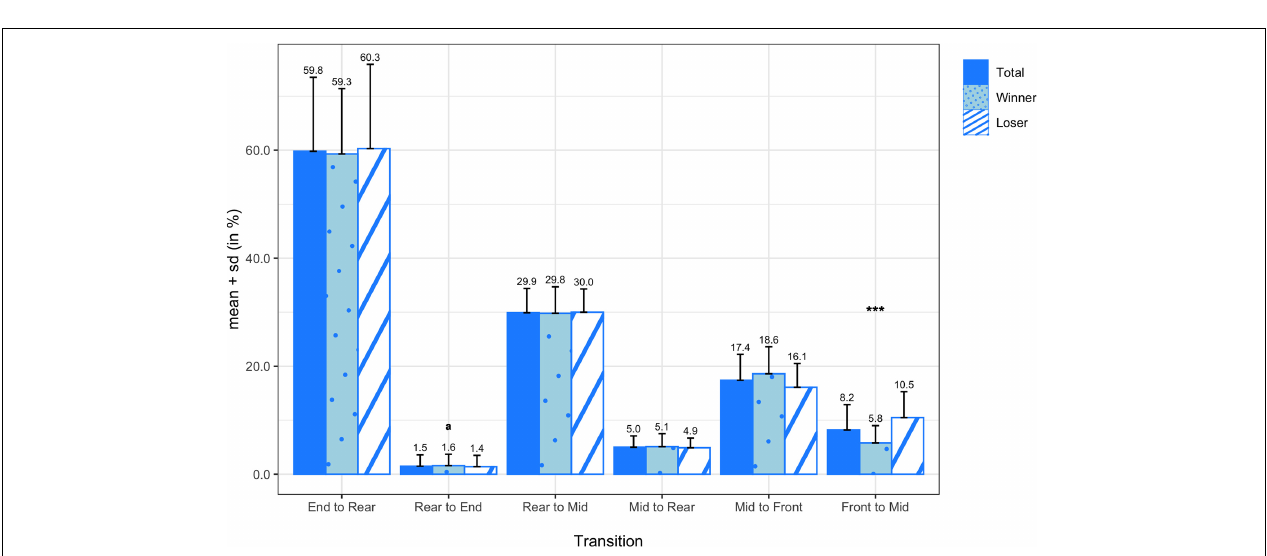
FIGURE 9 | Transition probabilities of attempted passes by zone for all teams, winning teams, and losing teams.